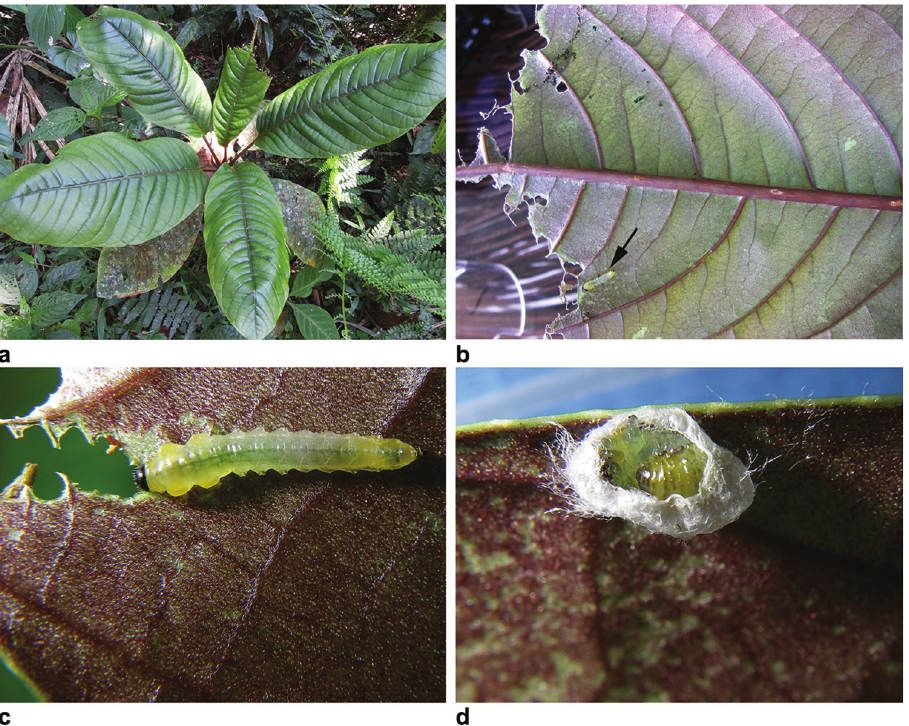
Figure 23. Pictures related to the single larva (P4228) found during a 3-week field trip. a Host plant with feeding damage on one of the leaves b, c Underside of that leaf occupied with the larva ( arrow ) d Cocoon partly damaged, showing the